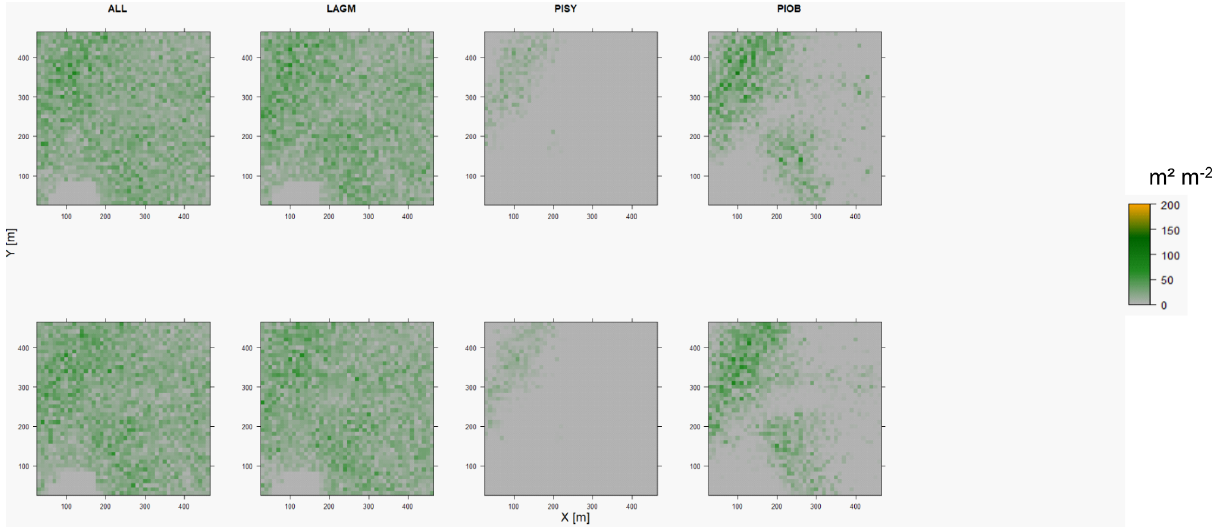
Figure D5. Leaf area index (LAI) values of the CryoGrid grid aggregated at year 2015 at Nyurba. Upper row shows LAVESI–CryoGrid coupled; lower row shows LAVESI simulations. LAGM: Larix gmelinii ; PIOB: Picea obovata ; PISI: Pinus sibirica ; PISY: Pinus sylvestris . Simulations with PISI were not possible.